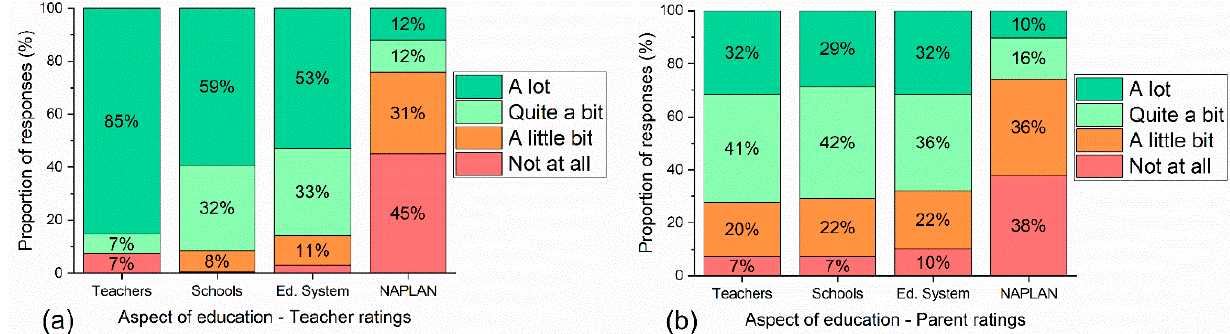
Figure 5. The perceived importance of public perception of different aspects of education for ( a ) teachers and ( b ) parents.